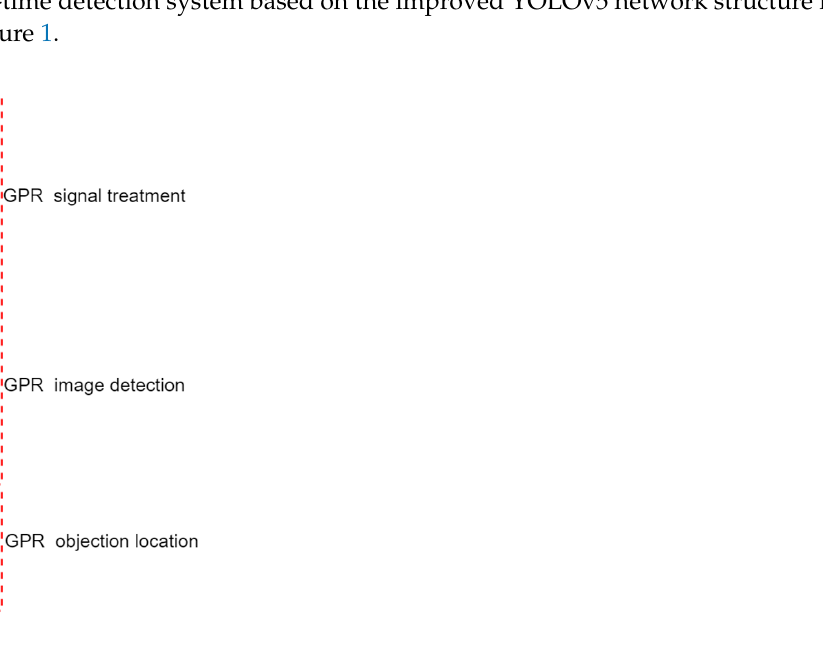
Figure 1. Schematic diagram of the real-time detection system of ground penetrating radar based on the improved YOLOv5 network